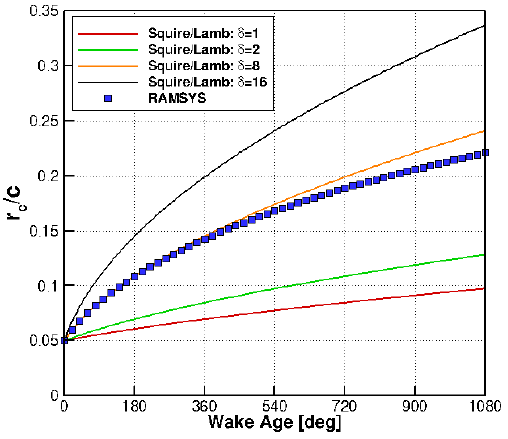
Figure 7. Growth of the vortex core radius as a function of wake age.